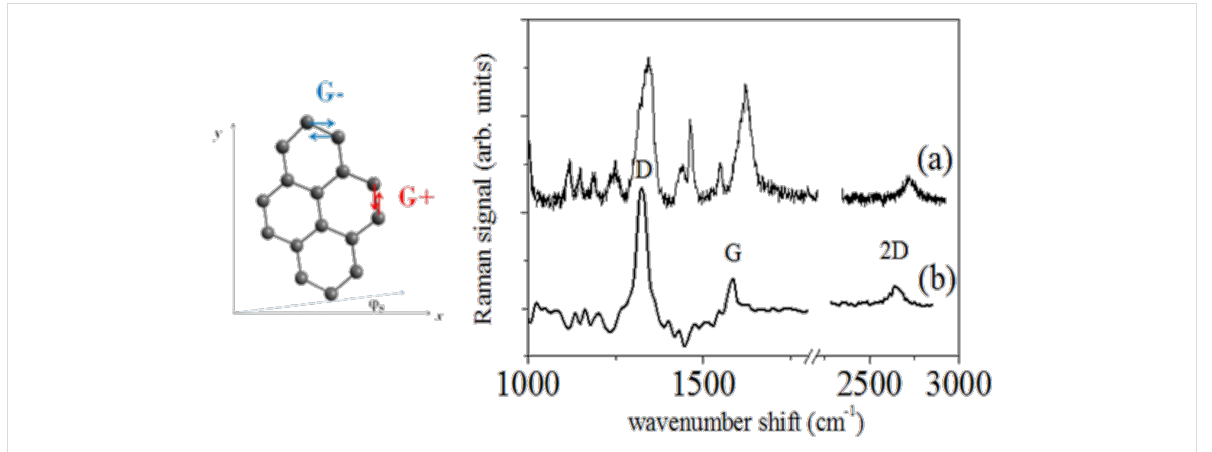
Figure 8: Schematic view of strain induced degenerate vibrational modes E 2g shown on the left. The uniaxial strain is directed along the x axis. The graphene lattice is turned with respect to the x axis at angle φ S . On the right, the Raman spectrum of the PMMA/graphene sample is shown as measured (a) and after subtraction of PMMA Raman components (b).